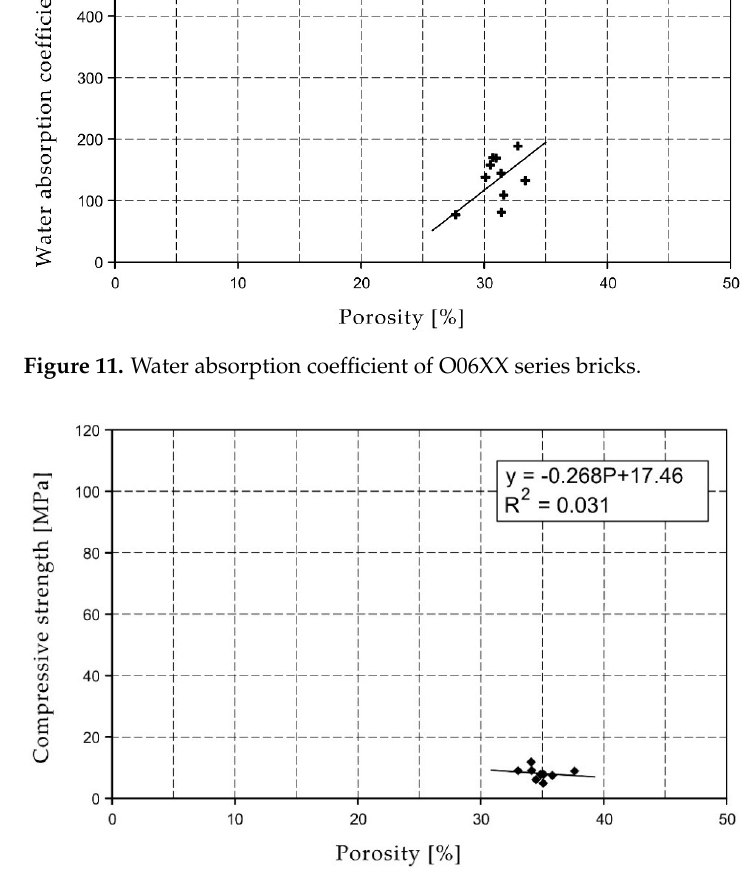
Figure 13. Water absorption coefficient of O07XX series bricks.